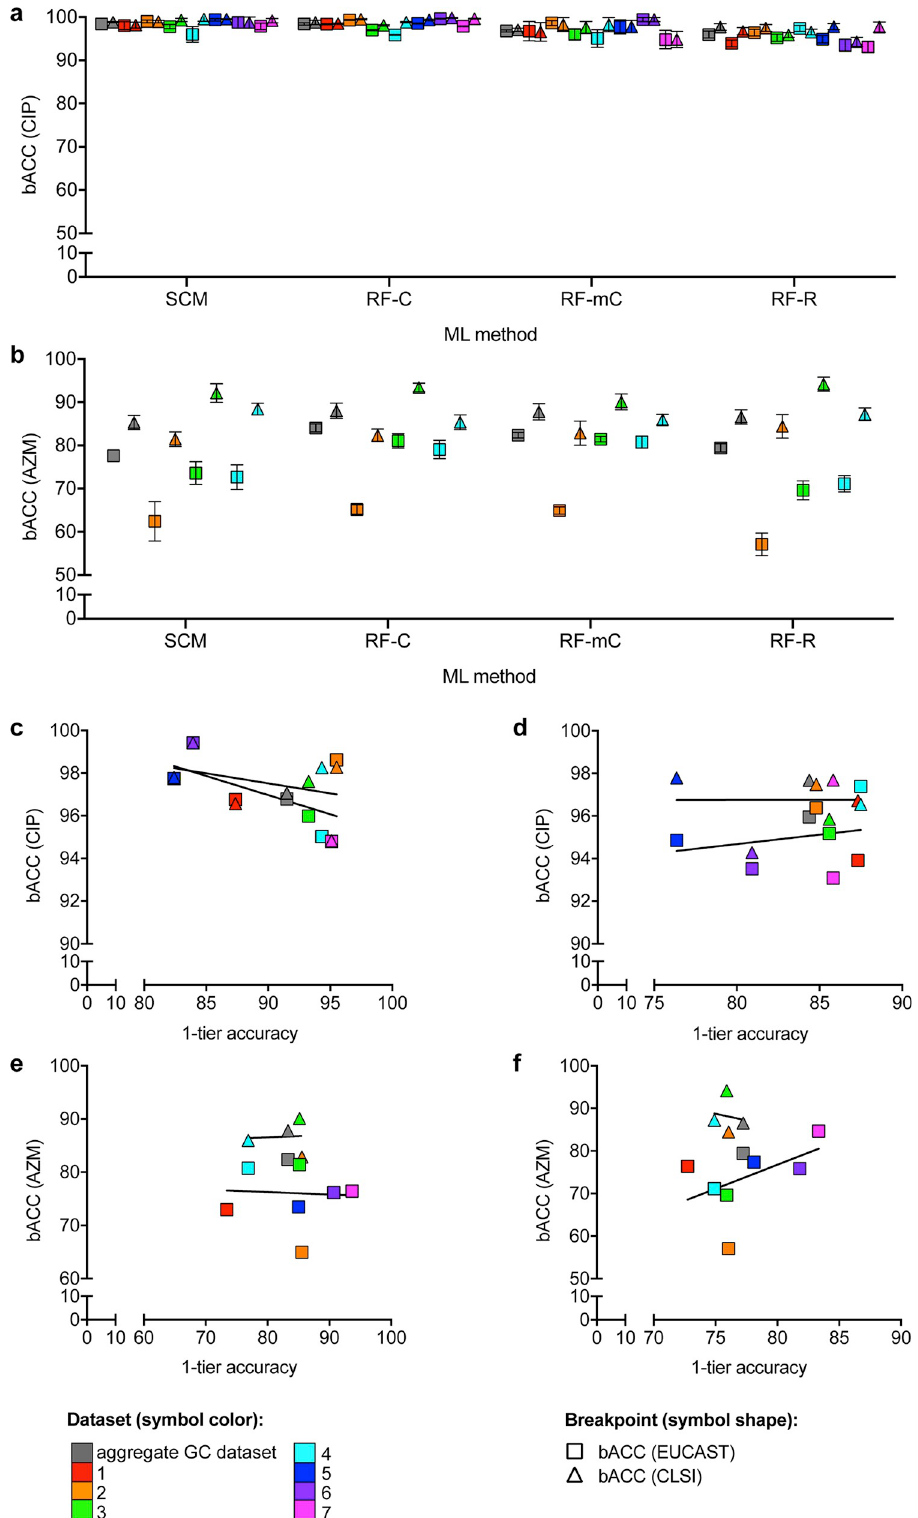
Fig 3. Differential performance of machine learning-based prediction models based on different resistance metrics in gonococci. Mean balanced accuracy (bACC) with 95% confidence intervals of predictive models for (a)